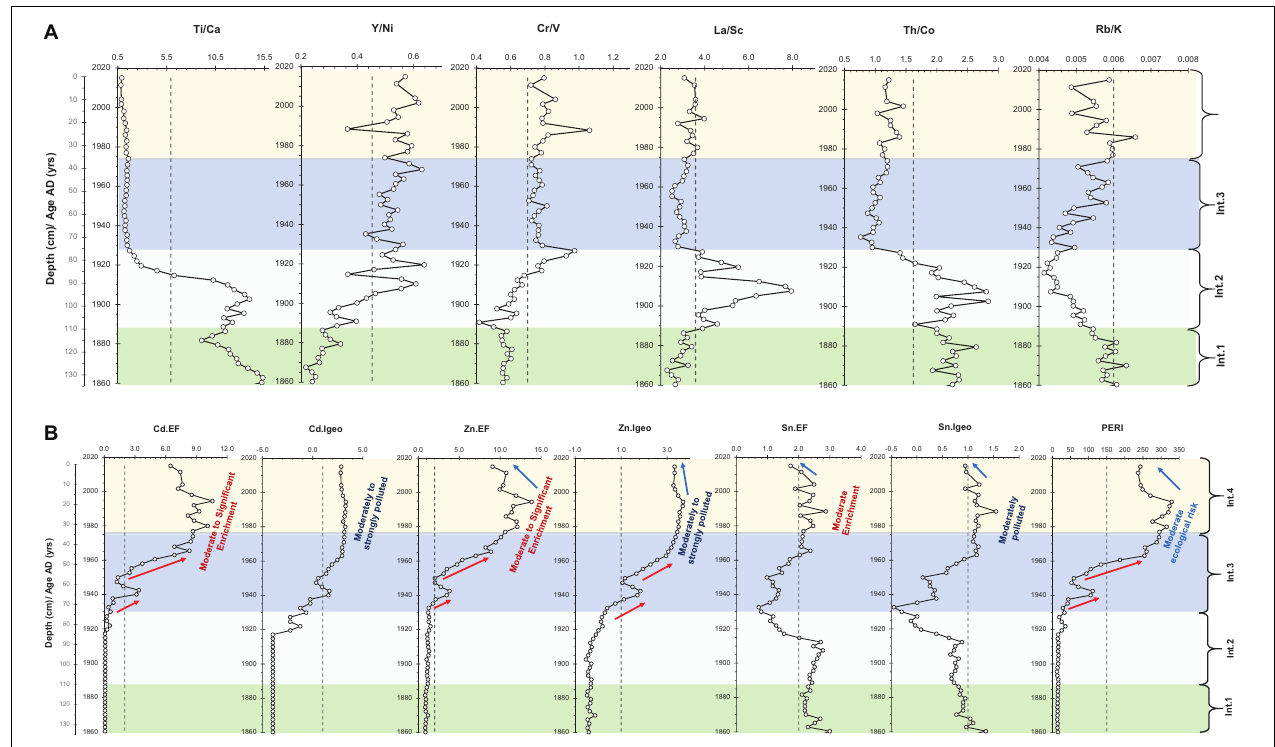
FIGURE 4 | Graphs as a function of depth and age (Anno Domini or AD) of: (A) ratios of chemical elements Cr/V, Y/Ni, Ti/Ca, Th/Ca, and Rb/K; (B) Igeo and enrichment factor (EF) values for Cd, Zn, and Sn, as well as PERI values. Dashed vertical lines in EF, Igeo and PERI values represent significant values according to Table 2 : EF > 2 and Igeo > 1. In the PERI graph, the dashed line signals the value of 150, above which ecological risk may be moderate to high.